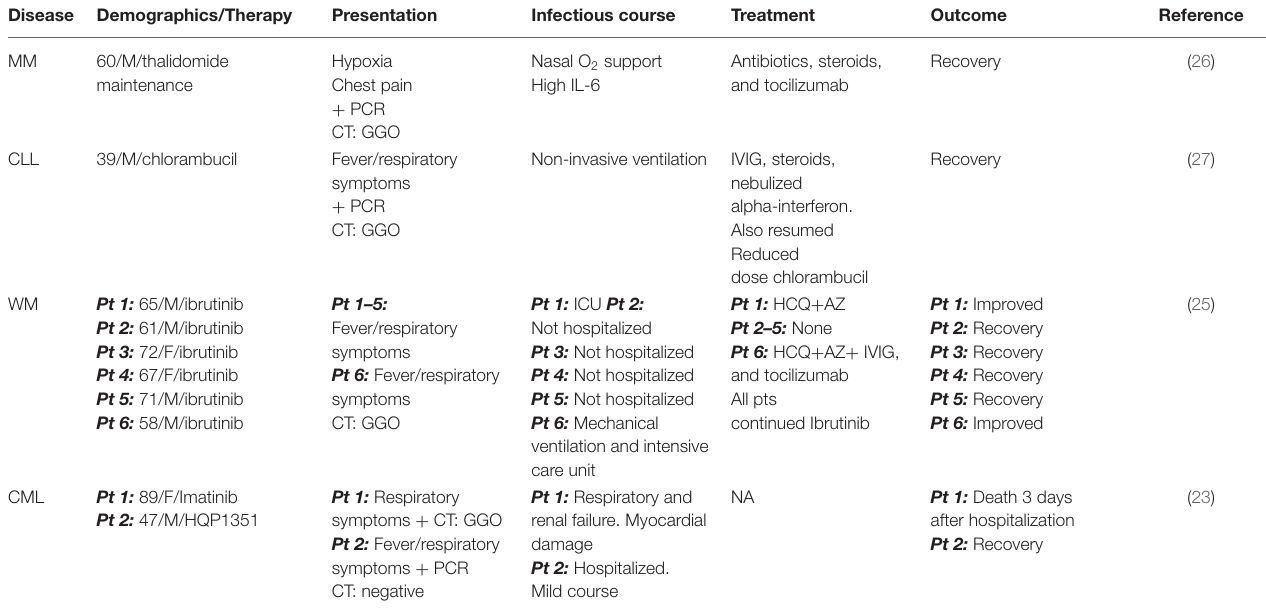
TABLE 2 | Published cases of COVID-19 in patients with hematologic malignancies. Disease Demographics/Therapy